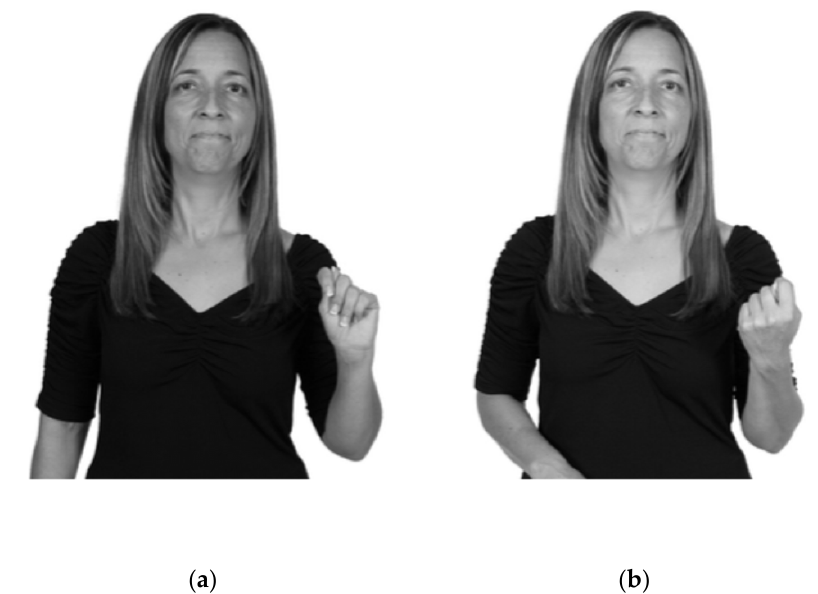
Figure 1. ( a ) Example of how the fingerspelled letter T is typically produced; and ( b ) How the fingerspelled letter T would be imitated with 180-degree reversal.